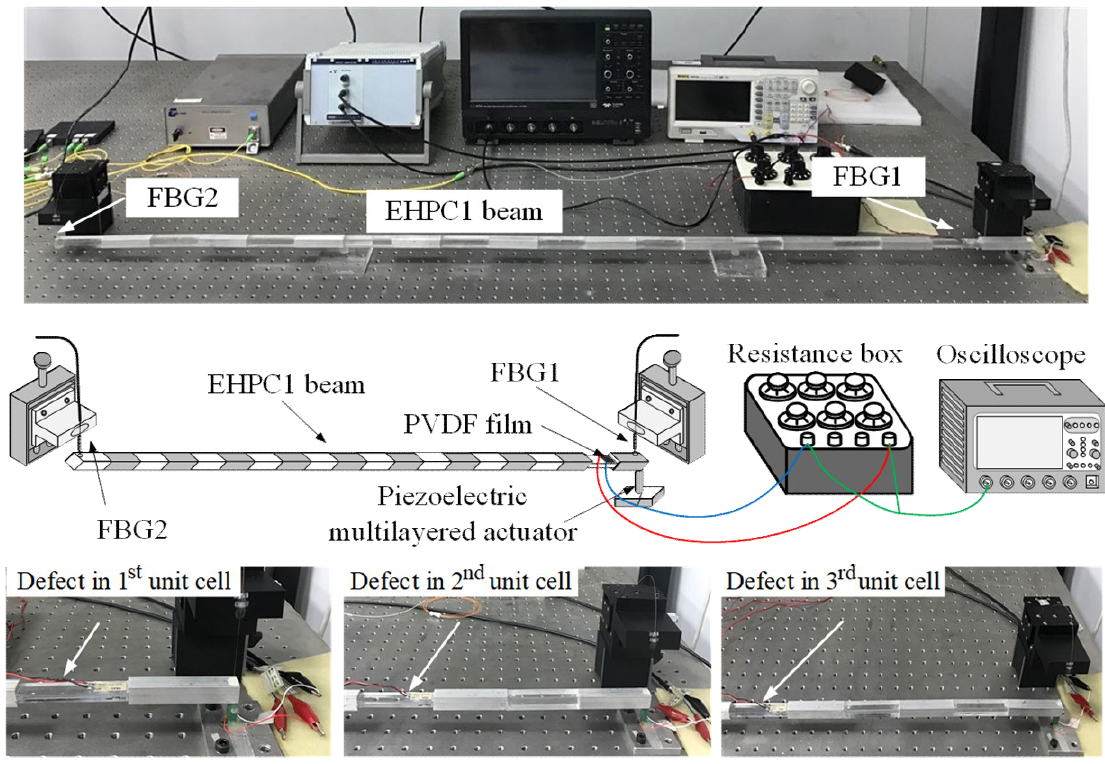
Figure 5. Experimental setup (including a fiber Bragg grating (FBG) displacement sensing system and the energy harvesting system) (color online).